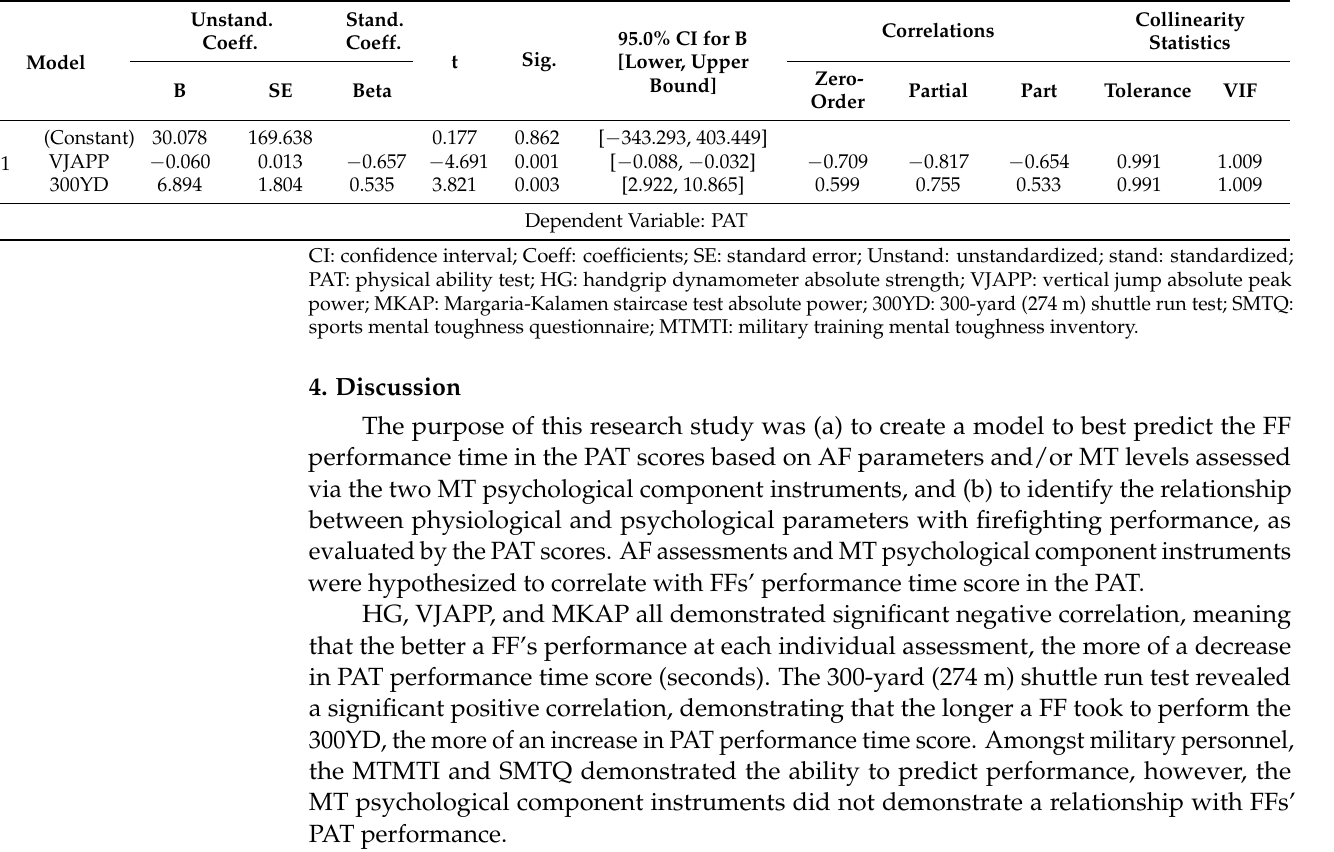
Table 6. Coefficients—PAT Scores, AF Parameters and MT